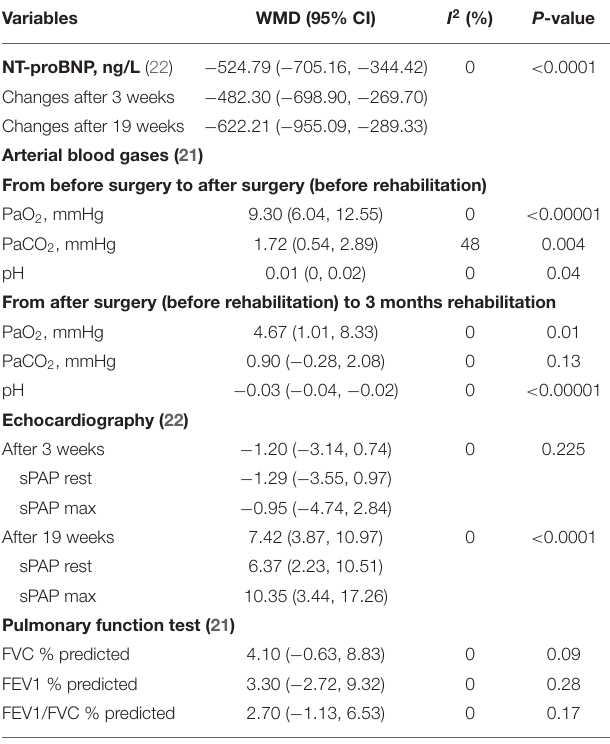
TABLE 4 | The effect of exercise training on NT-proBNP, arterial blood gases, echocardiography, and pulmonary function test in patients with CTEPH after